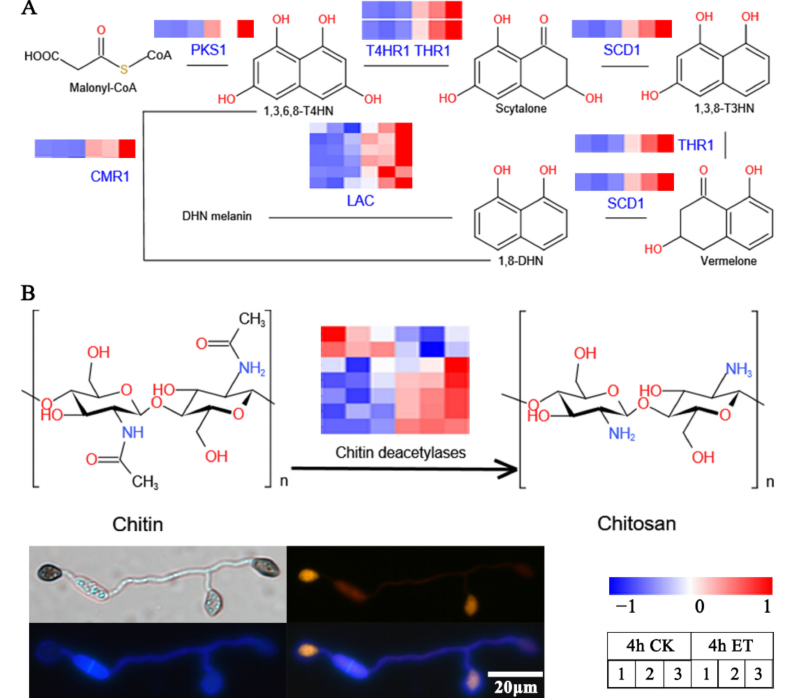
Figure 5. ET can significantly promote the expression of melanin synthesis genes, chitin deacetylase, and apoptosis-related genes. ( A ) Ethylene can significantly promote the upregulation of genes related to melanin synthesis. ( B ) Double-stained with Calcofluor targeting mainly chitin (blue) and Eosin Y targeting mainly chitosan (yellow). The bottom right table in the panel shows sample order information for the fungal gene expression